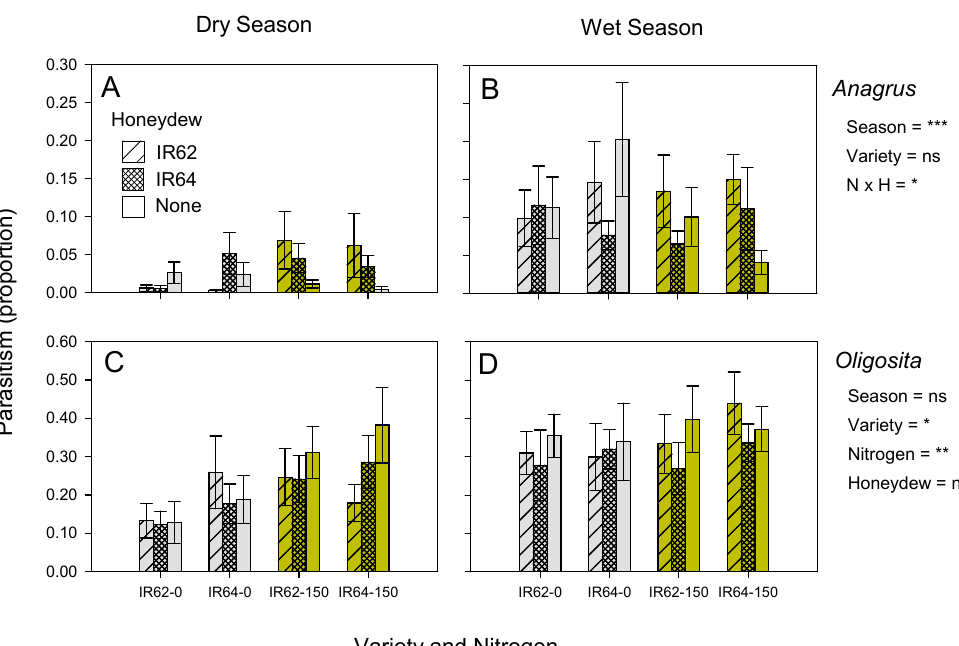
Figure 4. Parasitism of BPH eggs by Anagrus spp. ( A , B ) and Oligosita spp. ( C , D ) on plants with one of three honeydew treatments (IR62-derived honeydew added = hatched bars; IR64-derived honeydew added = cross-hatched bars; honeydew removed = open bars). Sentinel IR62 (resistance) and IR64 (susceptible) plants with BPH eggs were exposed in field plots with low (0 added) and high (150 kg ha − 1 ) nitrogenous fertilizer during the dry ( A , C ) and wet ( B , D ) seasons of 2013. Standard errors are indicated (N = 6); results of GLMs are indicated as ns = p > 0.05, * = p ≤ 0.05, ** = p ≤ 0.01 and *** = p ≤ 0.001.